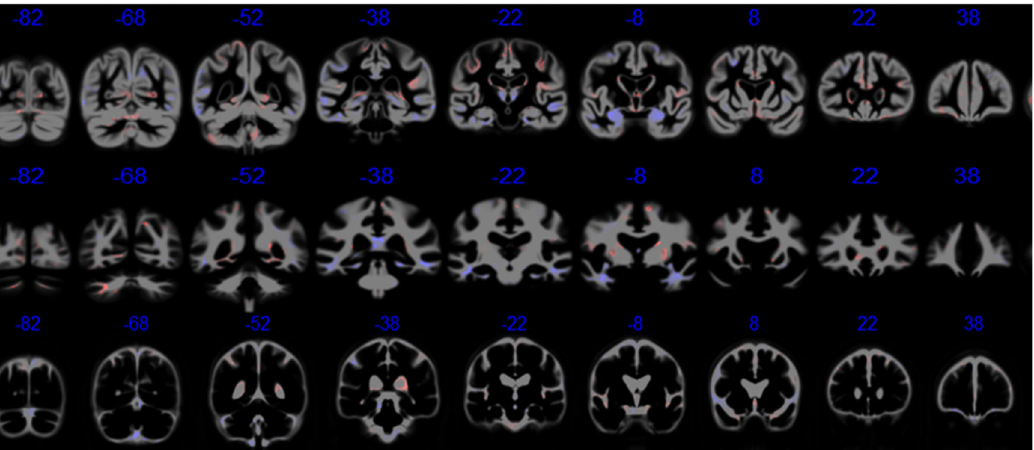
Figure 2. RLR classifier performances across different types of information and cognitive groups. Consistent with previous reports, grey matter (GM) tissue was more informative than white matter (WM) and cerebrospinal fluid (CSF). Interestingly, this difference decreases when a group with less severe cognitive decline is compared with the cognitively normal (CN) group.